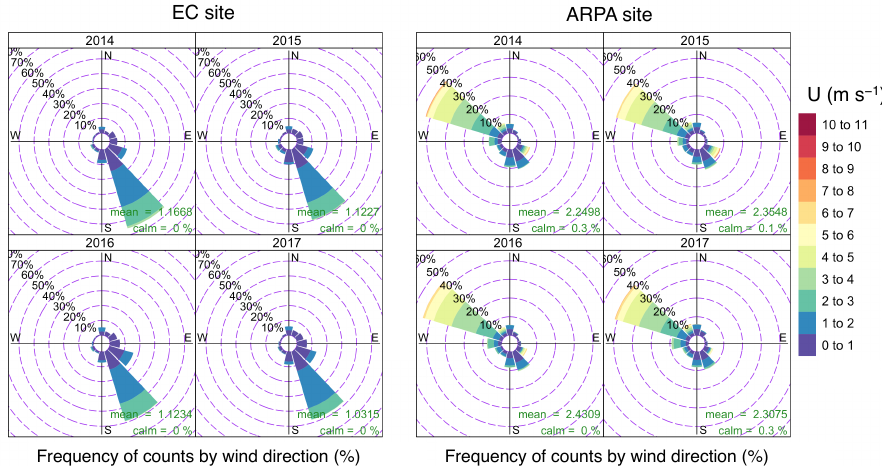
Figure A4. Daytime wind roses at the eddy covariance site ( left ) and at the Regional Authority (ARPA-VdA) site ( right ). Figure done with Openair R package